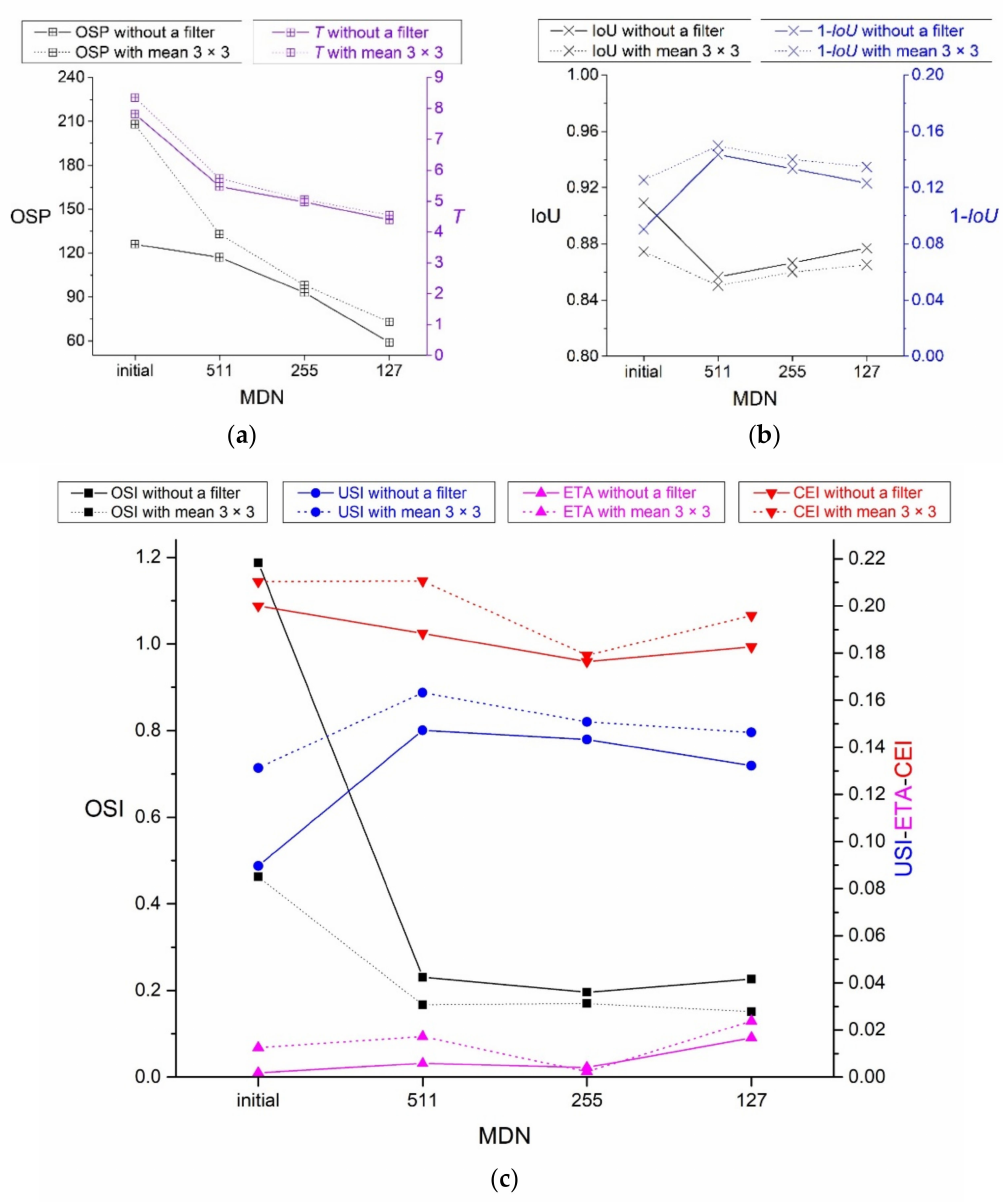
Figure 8. Effects of linear compression and mean filtering on segmentation evaluation parameters of ACFI: ( a ) OSP and segmentation time; ( b ) IoU and 1 − IoU ; ( c ) OSI-USI-ETA-CEI